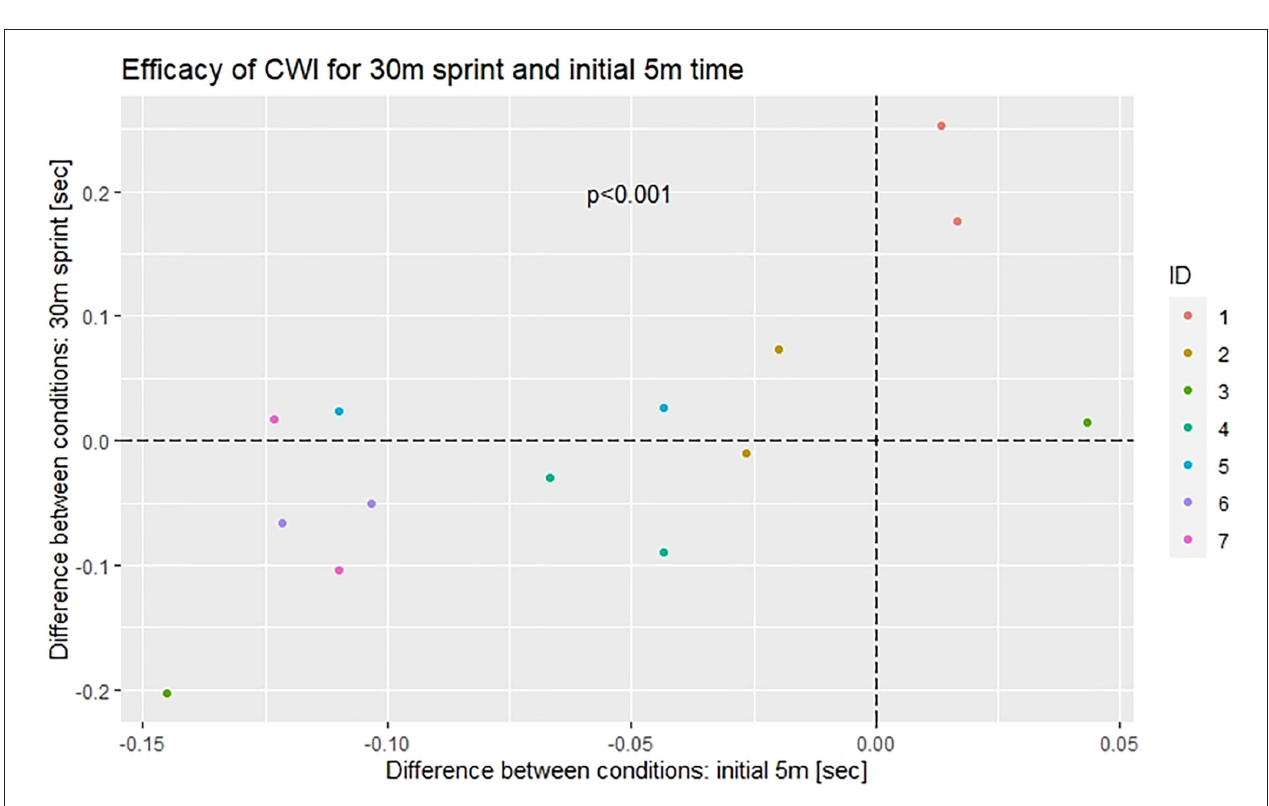
across the 2-fold replicated cross-over ( Figure 4 ). Salient is subject #1 with a consistent adverse response across distances and